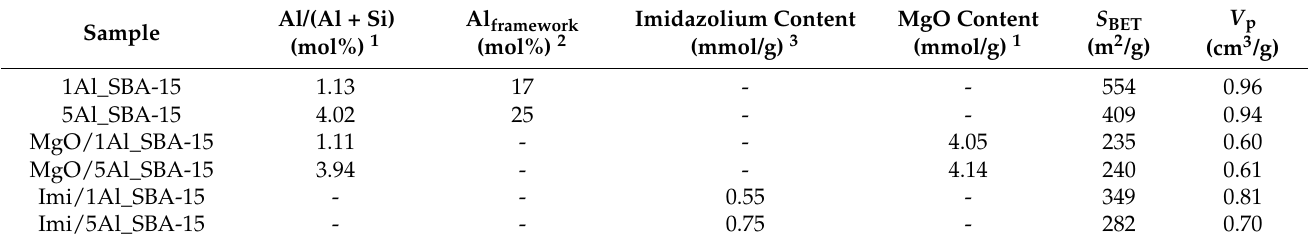
Table 1. Compositional and textural properties of supports and